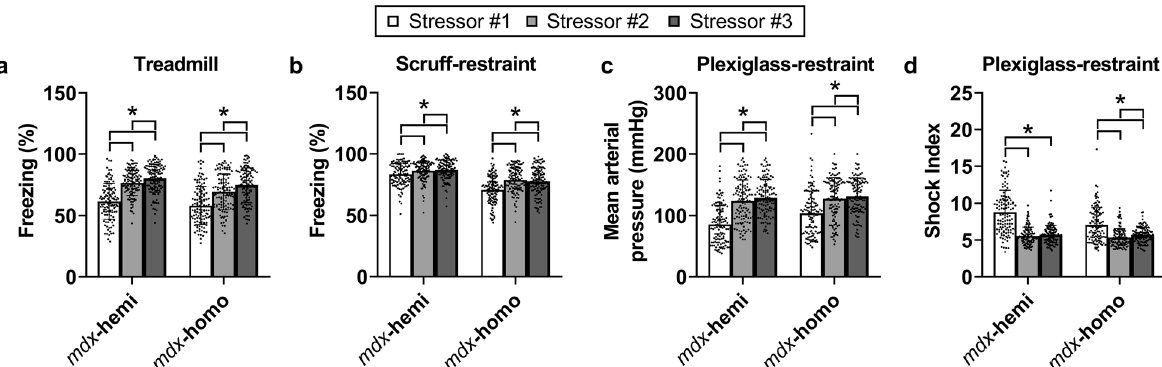
Figure 4. The habituation response of m dx mice to stress is stressor specific. ( a ) Freezing percentage (time spent inactive following a stressor) following repeated forced downhill treadmill exercise stress and ( b ) repeated scruff-restraint stress in male ( mdx -hemi) and female ( mdx -homo) mdx mice. ( c ) Mean arterial blood pressure and ( d ) shock index (heart rate/systolic pressure) during repeated 5 min plexiglass-restraint stress. Stressors were completed 1 week apart. Mdx -hemi (n = 119) and mdx -homo (n = 117). Data were analysed using a repeated measures two-way ANOVA with Tukey’s post‑hoc analysis. Data are mean ± SD. *p <